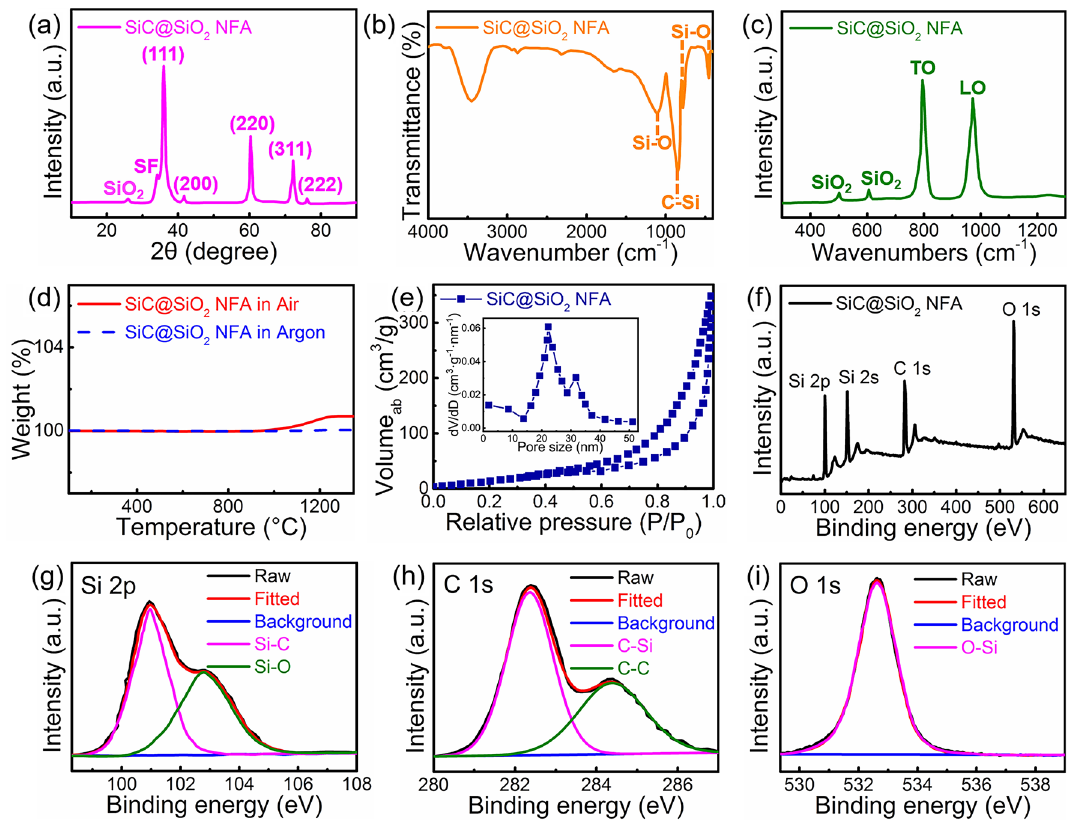
Fig. 3 Crystal structure, thermal stability, pore structure, and chemical composition of the SiC@SiO 2 NFA. a XRD patterns, b FTIR spectra, c Raman spectra, and d TGA curves, e N 2 adsorption/desorption isotherms and corresponding adsorption pore size distribution (inset), f XPS sur- vey spectrum and high-resolution g Si 2 p , h C 1 s , and i O 1 s XPS spectra for the SiC@SiO 2